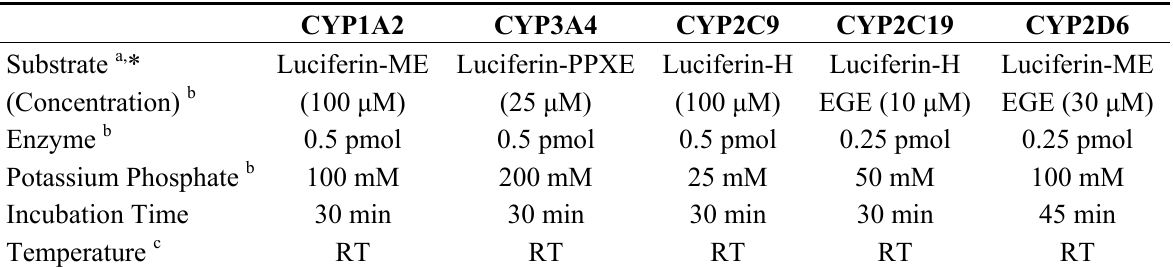
Table 4. Summary of reaction components and assay conditions for the luminescence CYP inhibition